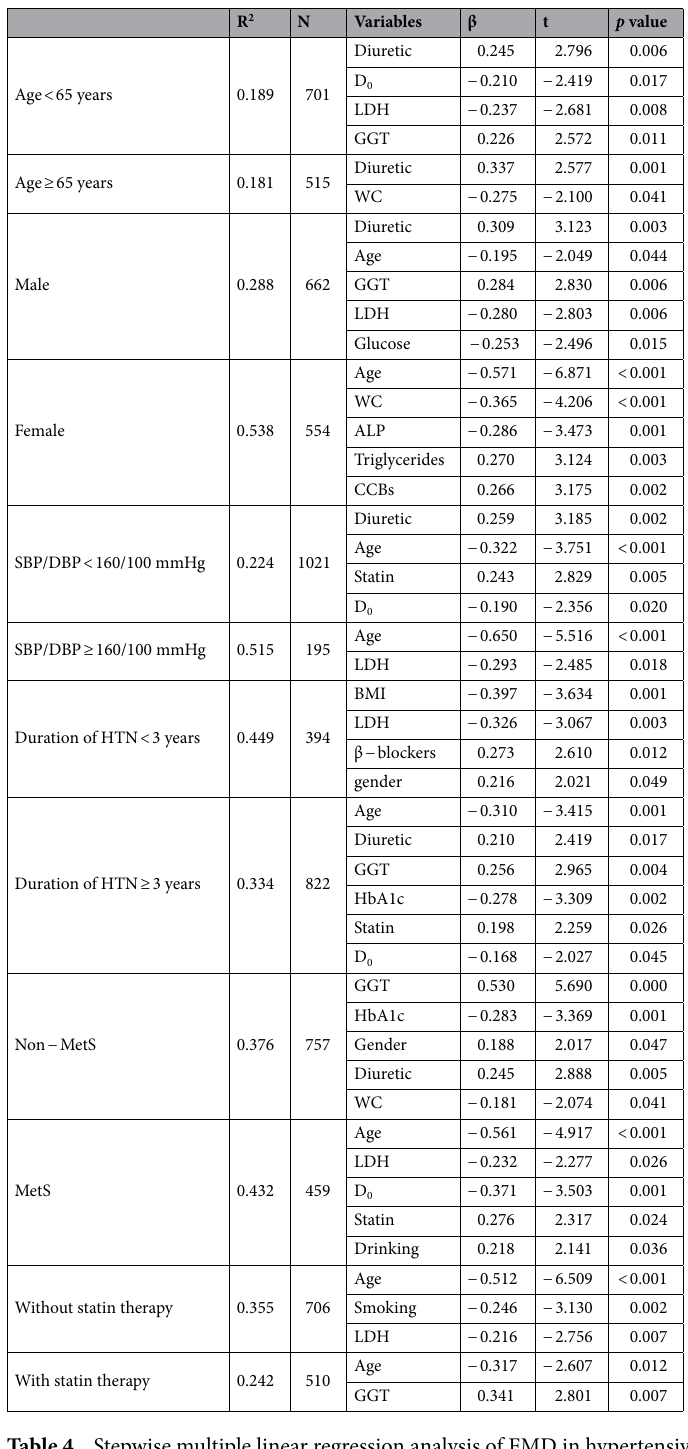
Table 4. Stepwise multiple linear regression analysis of FMD in hypertensives after stratification of age, gender, level of HTN, duration of HTN, MetS and statin therapy. FMD flow-mediated dilation; HTN hypertension; MetS metabolic syndrome; D 0 baseline diameter of anterior tibial artery; LDH lactate dehydrogenase; GGT gamma glutamyl transpeptidase; WC waist circumference; ALP alkaline phosphatase; BMI body mass index; HbA1c glycosylated hemoglobin; CCBs Calcium channel blockers (Yes = 1, No = 0), Diuretic: Yes = 1, No = 0, Statin: Yes = 1, No = 0, β-blockers: Yes = 1, No = 0, Gender: male = 1,female = 2, Drinking: Yes = 1, No = 0,Smoking: Yes = 1, No =